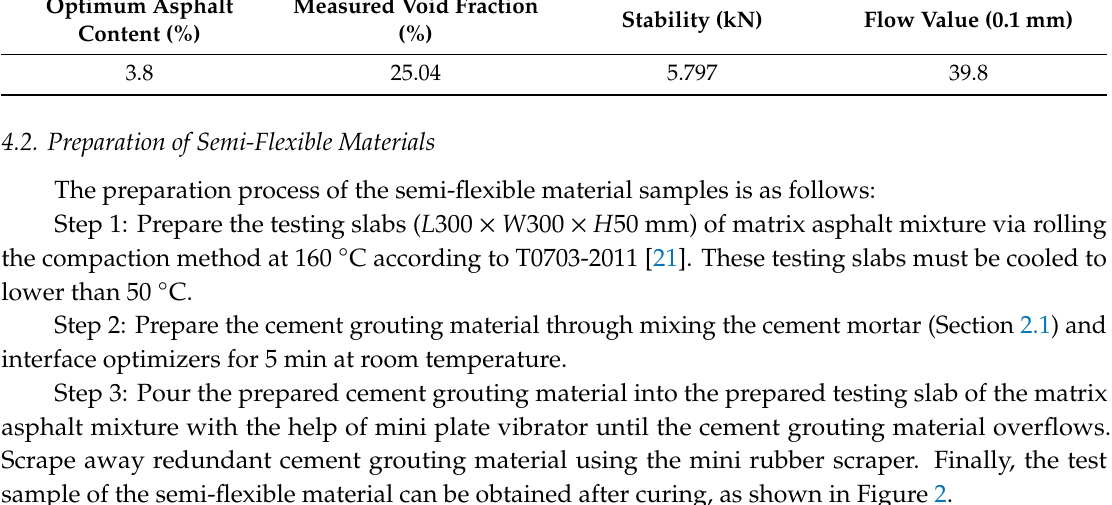
Figure 2. Prepared sample of semi-flexible material.